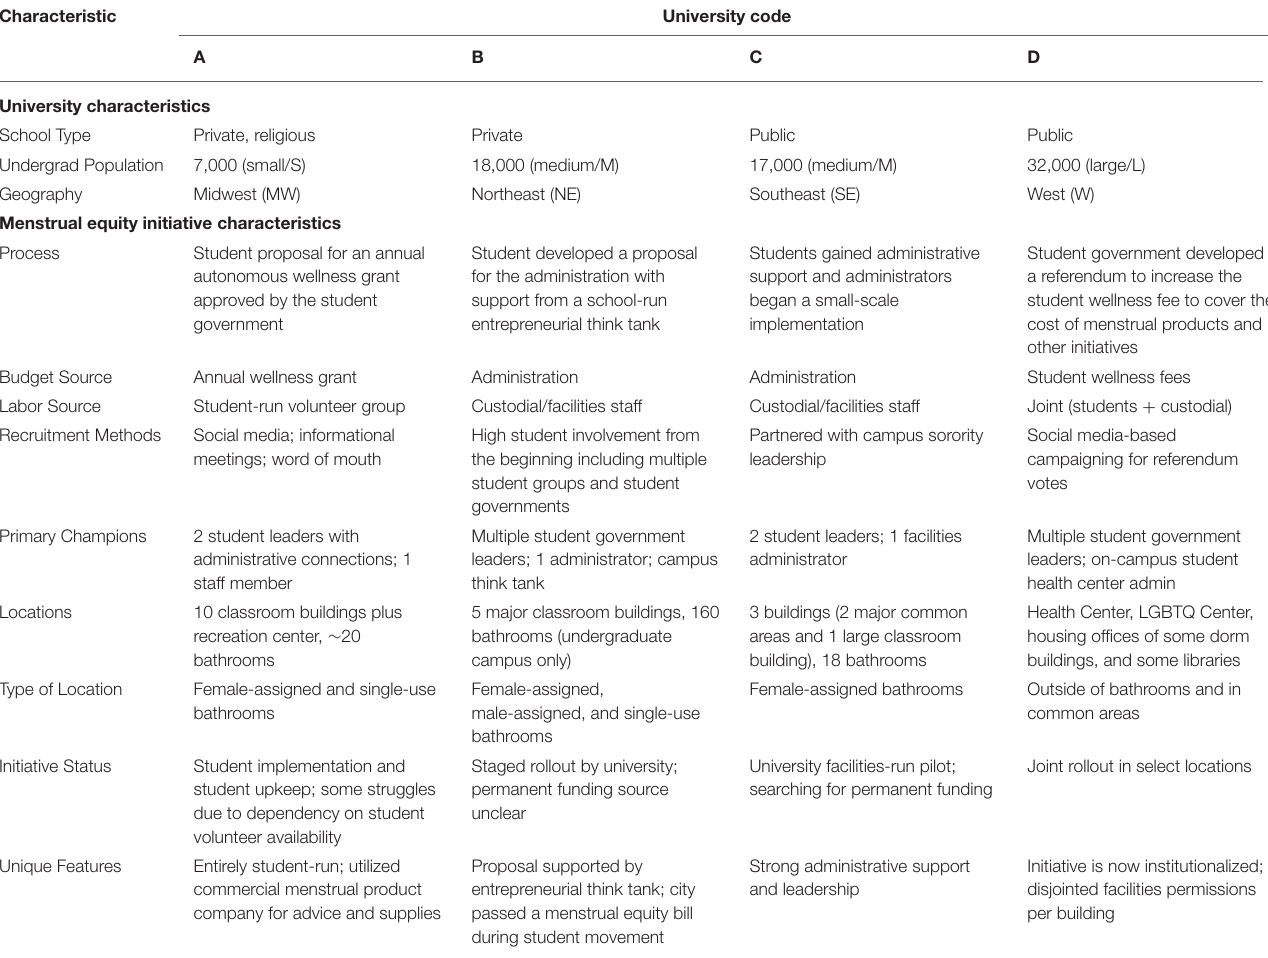
TABLE 3 | Characteristics of the menstrual equity initiatives across the four case study universities.